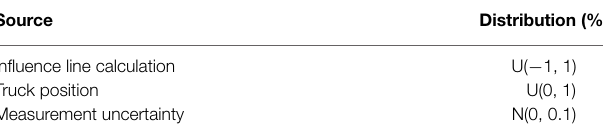
TABLE 1 | Parametric uncertainty.